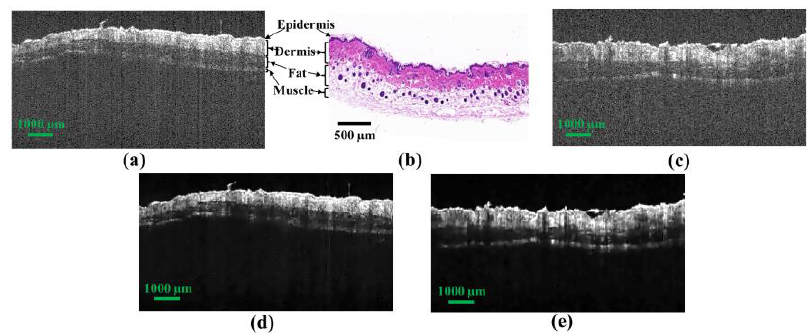
Figure 1. OCT image and corresponding histology of normal mouse skin tissue. ( a , c ) The original OCT image of the normal skin tissue (Scale bar: 1000 µm). ( b ) Histological sections of mouse skin tissues (Scale bar: 500 µm). ( d , e ) The noise-reduced OCT images with the proposed method corresponding to ( a , c ) (Scale bar: 1000 µm).